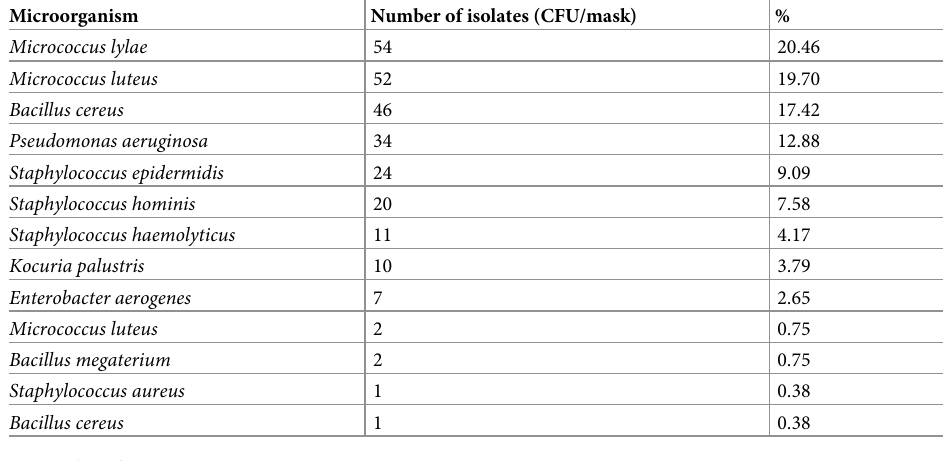
Table 1. Numbers of microorganisms obtained from 59 used masks from 30 healthcare